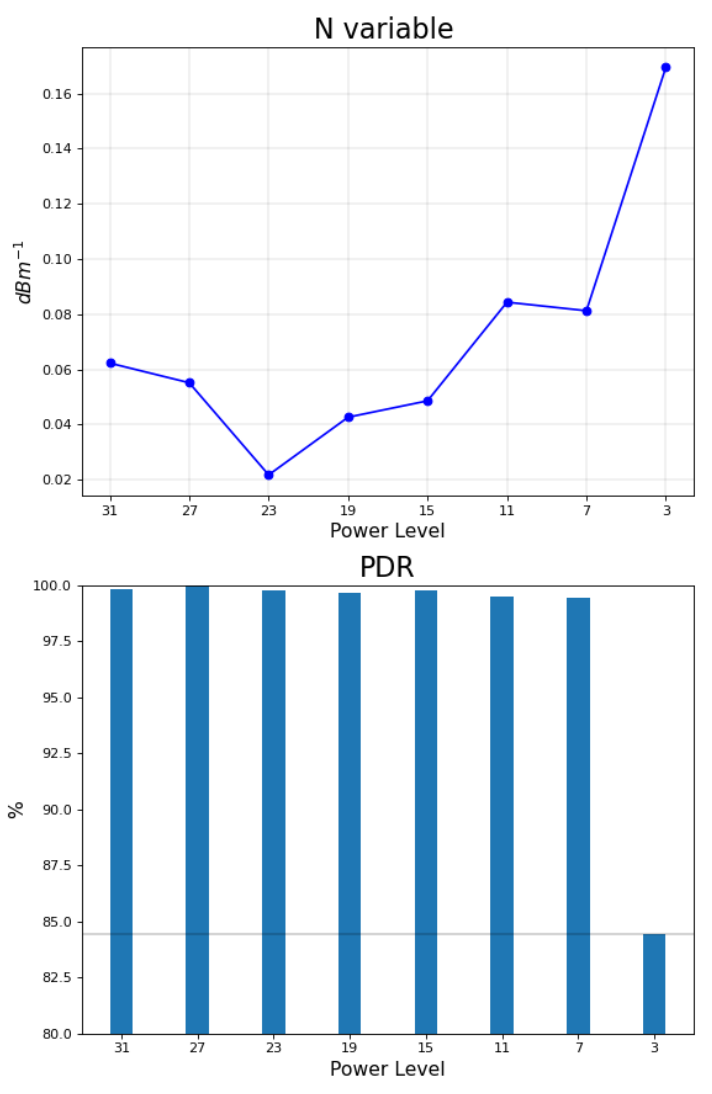
Figure 11. N vs. PDR for different power